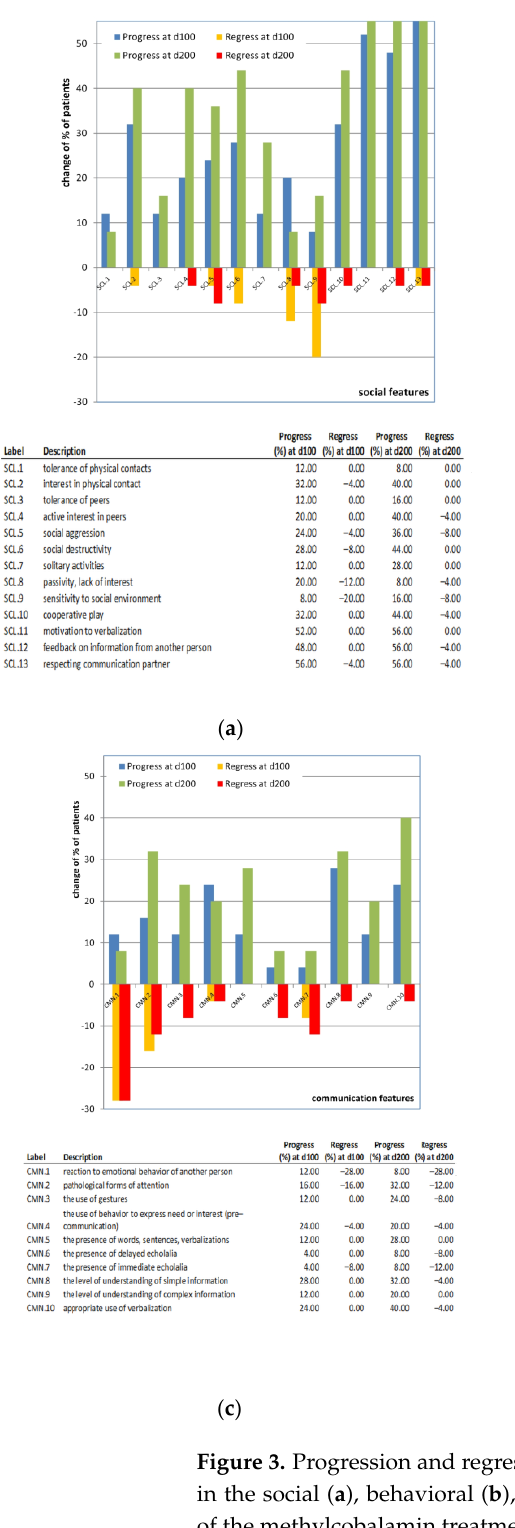
Table 2. Biochemistry parameters of the treatment group (Bio) during the study (d0 — before the treatment, d100 — at day 100 of treatment, d200- at day 200 of treatment), and the evaluation of the overall absolute and relative changes (d200 vs. d0 values) explained by Cohen delta. Parameter.